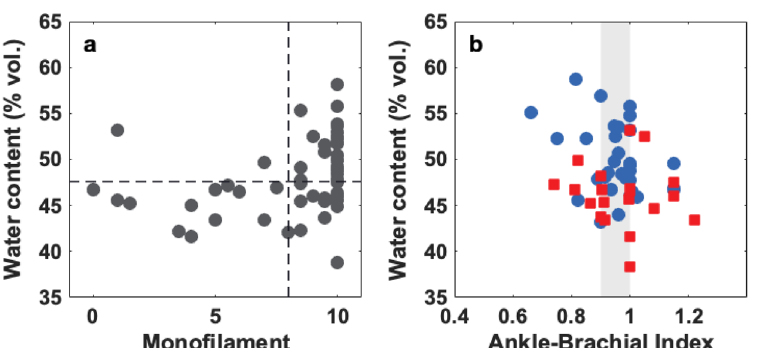
Figure 7. ( a ) Water content averaged over the two feet soles as a function of the minimum SMW score of the two feet for each patient ( n = 60 ). ( b ) Water content averaged over the foot sole as a function of the ankle- brachial index (ABI) for diabetic patients with complications (red squares, n = 22 ) and diabetic patients with no complications (blue circles, n = 32 ). The grey shaded area indicates ABI “borderline” values (0.91–0.99), ABI values ≤ 0.90 are considered abnormal, the ABI normal range is defined from 1.0 to